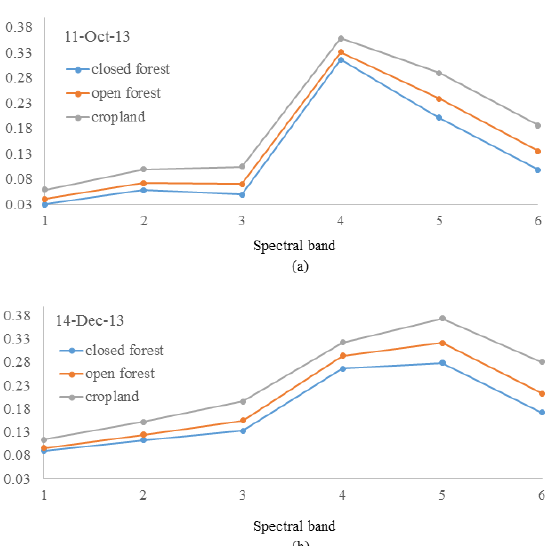
Table 2. Overall accuracy (OA) of the multi-temporal classifications.